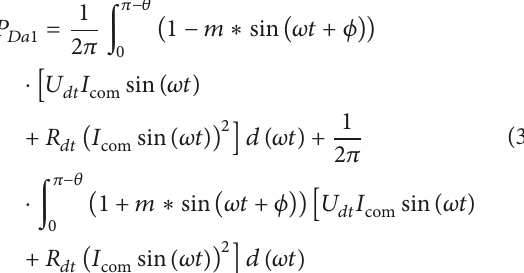
Figure 8: Three-level space vector